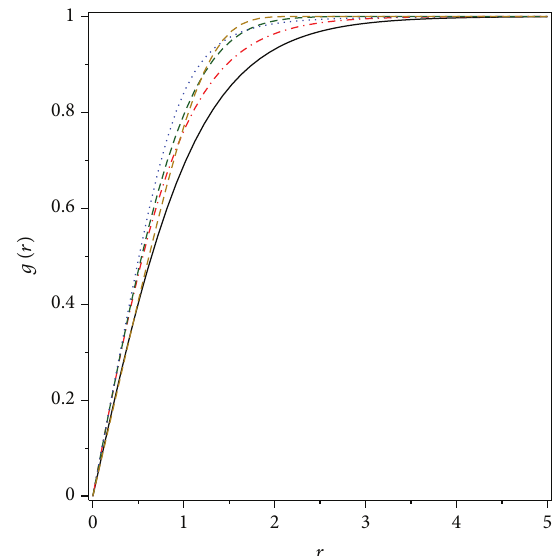
Figure 1: Solutions to 𝑔(𝑟) given by (32) (dash-dotted red line), (37) (dashed green line), (45) (dotted blue line), and (50) (long-dashed goldline).Here,thesolidblacklineisthestandard(numerical) 𝑛 = 1 ANO solution.